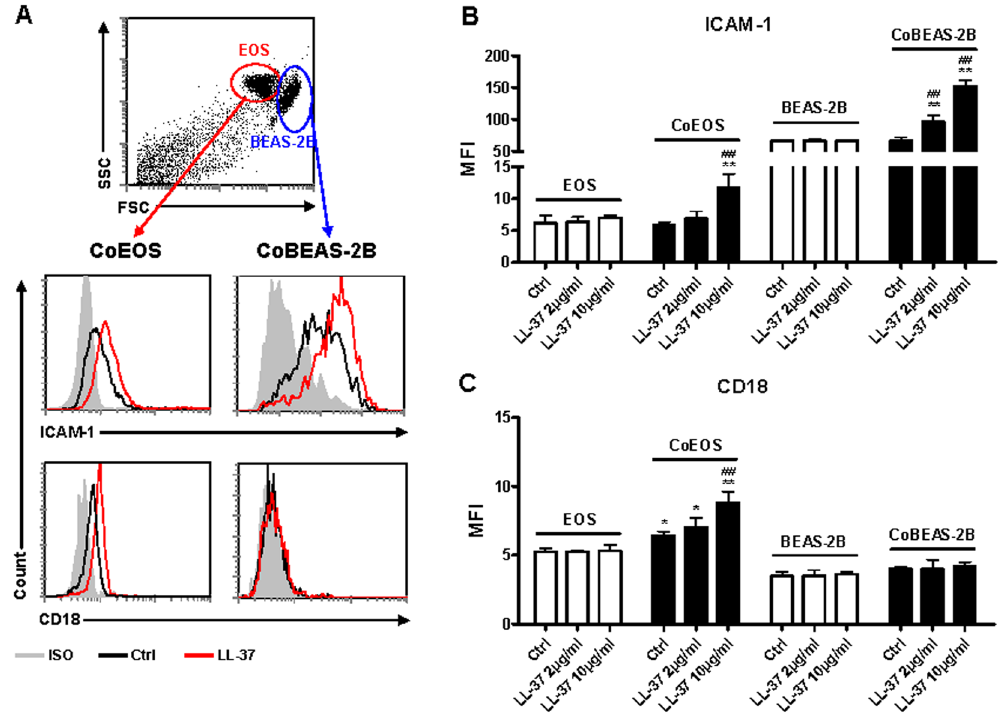
Figure 1. Effects of LL-37 on the surface expression of ICAM-1 and CD18 on eosinophils and BEAS-2B cells in the co-culture. Human eosinophils (3 × 10 5 ) and BEAS-2B cells (1 × 10 5 ) were cultured either together or separately with or without 2 or 10 μ g/ml LL-37 for 20 h. ( A ) representative dot plot and histograms illustrating differential flow cytometric analysis of surface expression of ICAM-1 and CD18 on eosinophils or BEAS-2B cells in the co-culture of triplicate independent experiments showing essentially similar results. ( B,C ) quantitative results of surface ICAM-1 ( B ) or CD18 ( C ) expression on eosinophils and BEAS-2B cells are presented as MFI. EOS, eosinophils; CoEOS, eosinophils in co-culture; CoBEAS-2B, BEAS-2B cells in co-culture. Results are shown as arithmetic mean plus SD of triplicate independent experiments. * P < 0.05, ** P < 0.01 when compared between denoted groups and eosinophil/fibroblast control groups. ## P < 0.01 when compared between denoted groups and co-culture control